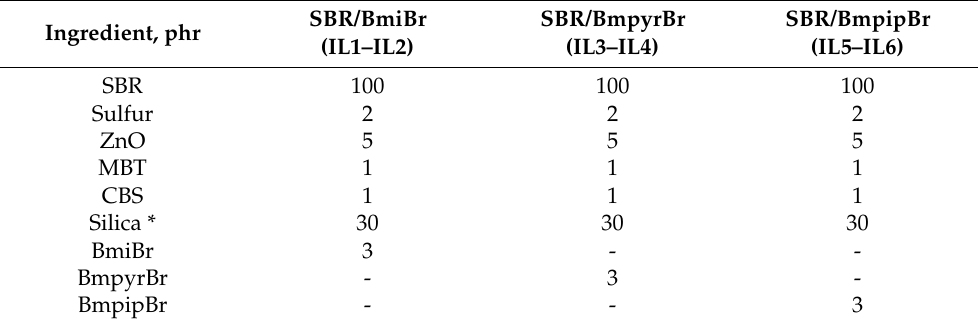
Table 3. General recipes of SBR compounds containing ionic liquids (phr); (BmiBr, 1-butyl-3- methylimidazolium bromide; BmpyrBr, 1-butyl-1-methylpyrrolidinium bromide; BmpipBr, 1-butyl-1- methylpiperidinium